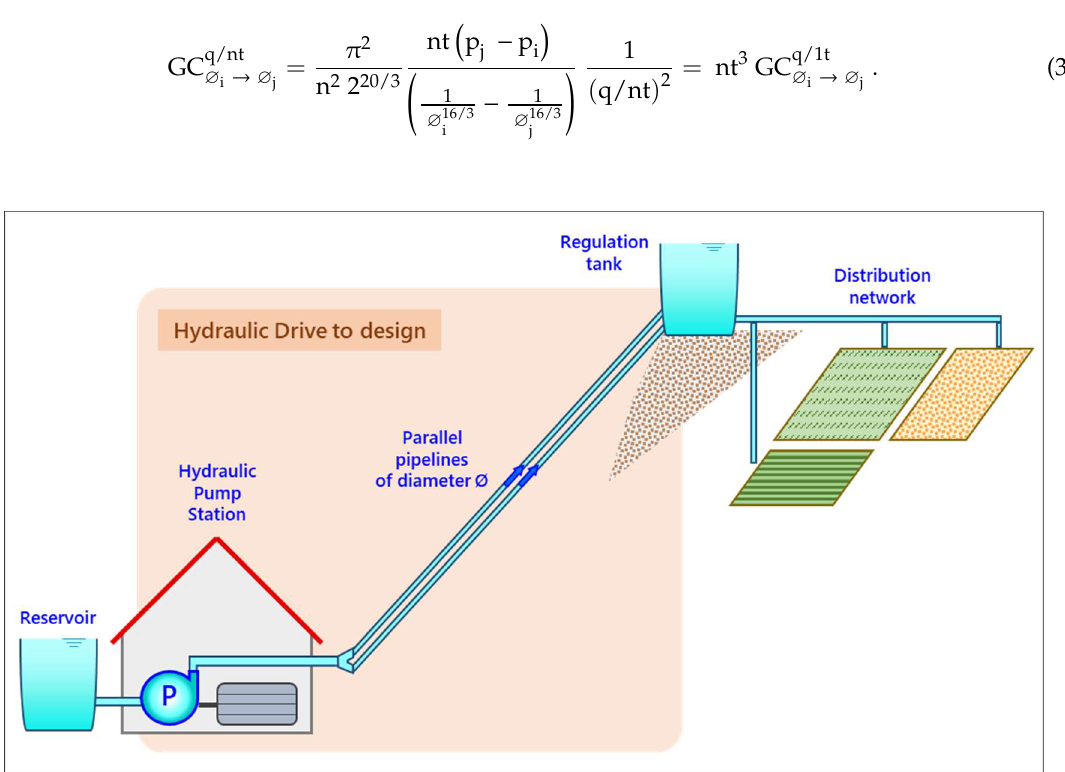
Figure 3. Parallel pipe configuration of the hydraulic drive.